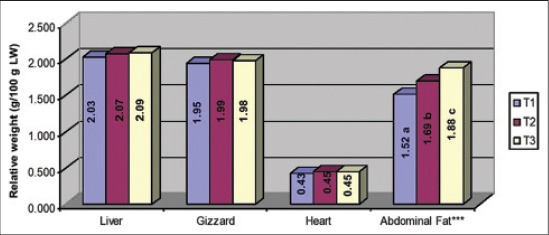
Effect of second line limiting amino acid deficit diets on relative weights of liver, gizzard, heart and abdominal fat of broilers, T1- Control; T2- Moderate SLAA deficit diet; T3- High SLAA deficit diet; *Methionine + Cysteine, a-cWithin a column means bearing different superscripts significantly (p<0.05) differ